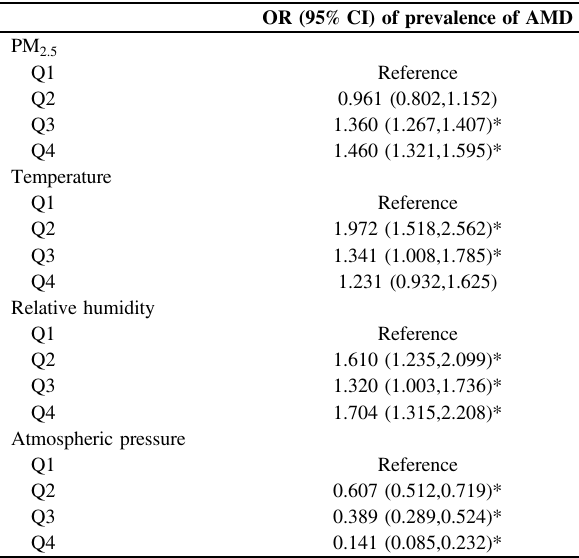
Fig. 2 Characteristics of meteorological factors and ambient PM 2.5 levels in 10 provinces of China. (a): mean levels of PM 2.5 from 2007 – 2016 by established satellite-based spatiotemporal models; (b, c, and d): meteorological data (temperature [b], relative humidity [%; c], and atmospheric pressure [hPa; d]) from 2007 – 2016 were calculated by ERA5. Meteorological data were matched to participants ’ home addresses by latitude and longitude as the long-term exposure at the individual level. Table 2 Adjusted OR (95%CI) for AMD with meteorological factors and PM 2.5 separately, treated as